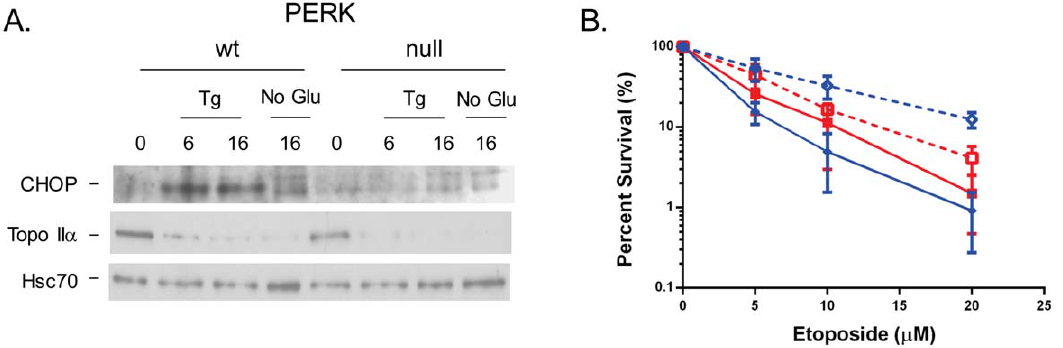
Figure 4. Altered sensitivity to etoposide is downstream of PERK and independent of changes in Topo II a expression. A. PERK wild- type and knock-out cells were treated with thapsigargin for 0, 6 and 16 hrs or incubated in glucose-free media for 16 hrs. Cell lysates were prepared for western blotting as in Figure 1 and blotted with the indicated antisera. B. PERK wild-type (blue) and null (blue) cells were pretreated with (dotted lines) or without (solid lines) thapsigargin and then incubated with the indicated concentrations of etoposide. Clonal survival assays were performed as in Figure 2.